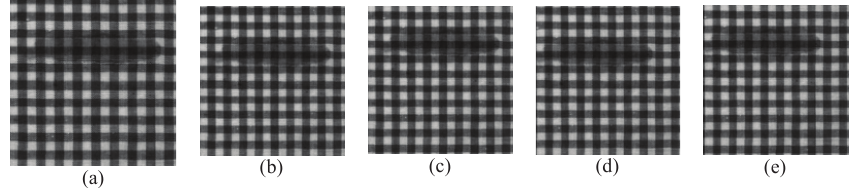
Figure 3. (a) Input defective image; (b) Cropped image obtained from top-left corner of the test image; (c) Cropped image obtained from bottom-left corner of the test image; (d) Cropped image obtained from top-right corner of the test image; (e) Cropped image obtained from bottom-right corner of the test image.